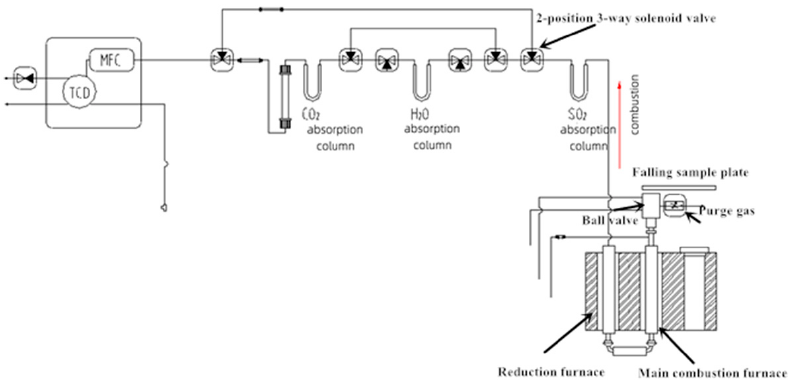
Figure 4. Schematic diagram of solid sampling nitrogen and sulfur analyzer. TCD means a thermal conductivity detector; MFC means mass flow controller.